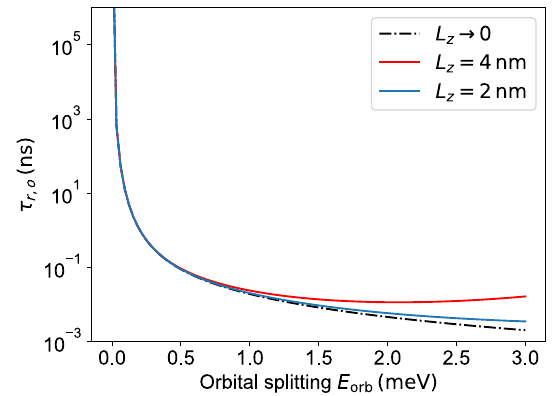
FIG. 10. Orbital relaxation time in a circular QD ( L x = L y ), with L z as the remaining parameter. L z → 0 illustrates the fic- titious case of a completely 2D electron (where phonon bottle- necking along the z direction is absent), while L z = 4 nm is a reasonable upper bound for the localization of the electron wave function in z